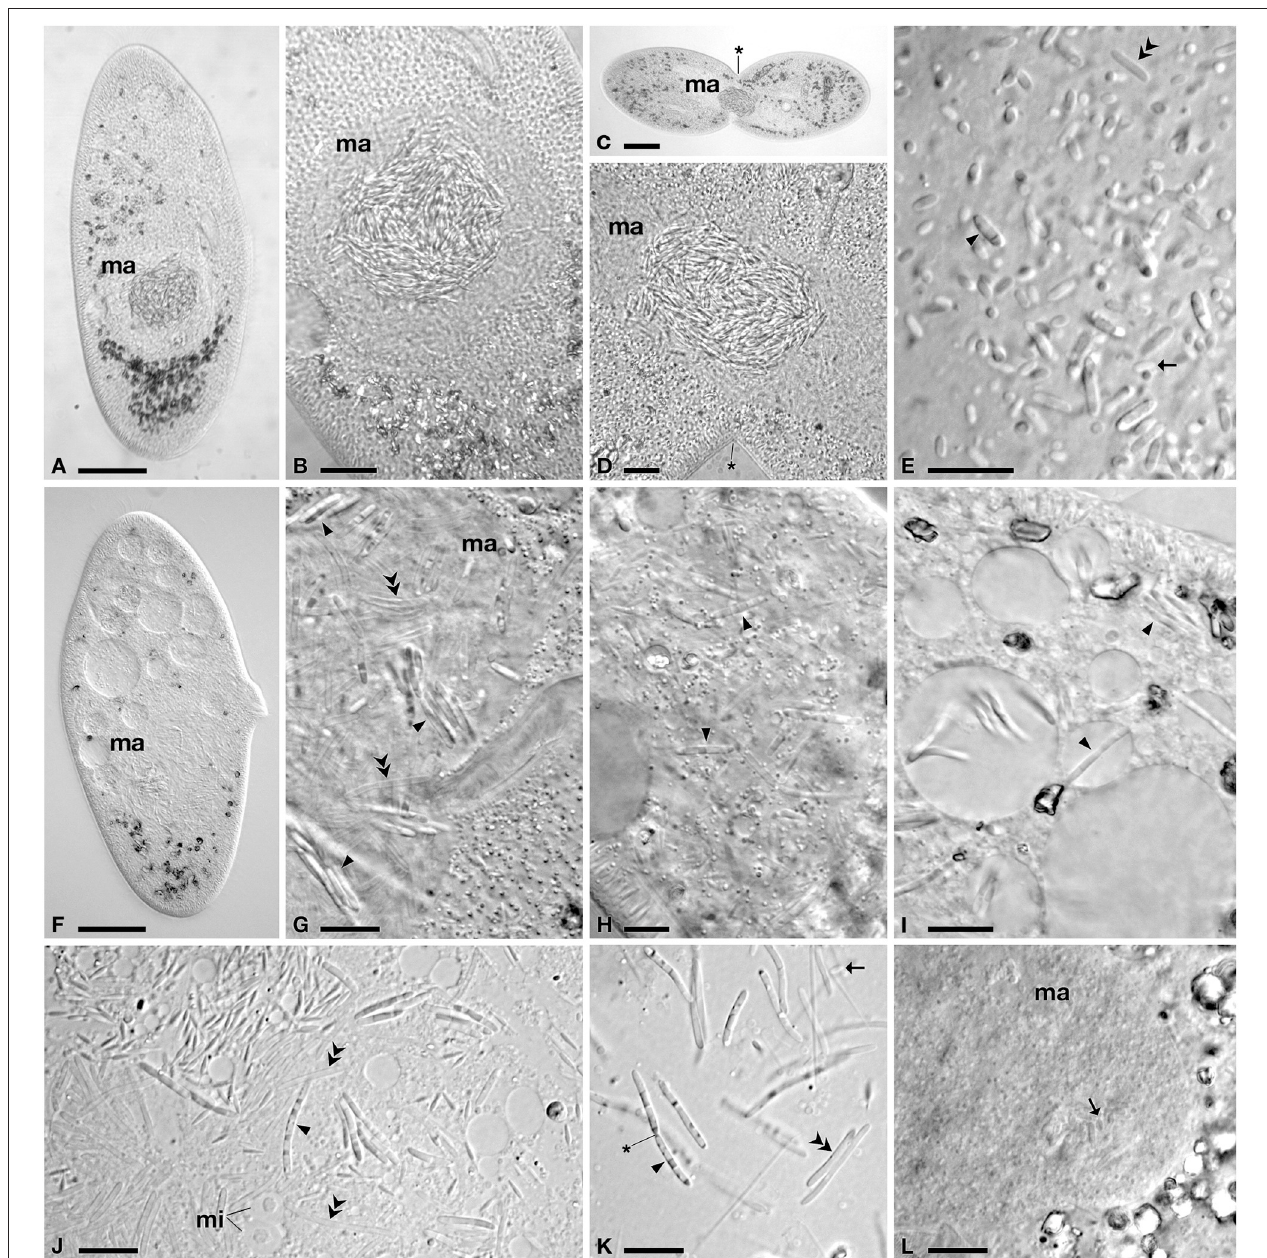
FIGURE 1 | Light microscopy of infected cells of P. multimicronucleatum . (A–E) TP2 cells a few weeks after environmental sampling and (F–K) after 1 year in culture. (A) Whole cell with macronuclear infection. (B) Infected macronucleus ( ma ), with bacteria clustering inside. (C) Infected cell undergoing division and (D) detail of its ma , showing absence of connecting piece. (E) Bacterial forms released after ma squashing, showing classical size and morphology of reproductive ( rf ) and infectious ( if ) forms. (F) Whole cell with macronuclear infection after 1 year of cultivation, in which bacterial cells are less visible. (G) Detail of infected ma , in which if cluster together in small groups, among a large number of transient forms ( tf ). (H) if in host cytoplasm. (I) Detail of if in host cytoplasm inside and outside vacuoles. (J) Detail of host vesicular type micronuclei ( mi ) and if , showing some changes in morphology, such as size and unusual striated/dotted pattern. (K) if undergoing binary fission and tf after cell squashing. (L) ma of strain PC6, infected by bacteria during cross-infection experiments, showing classical rf morphology. Arrowheads indicate infectious forms, arrows reproductive forms and double arrowheads transient forms. The asterisk indicates the cleavage furrow. Bars stand for 30 µ m (A,F) , 20 µ m (C,H) and 10 µ m (B,D,E,G,I–L) . daughter cells within MA pieces which, in many cases, were not equally shared in terms of size, suggesting that the bacteria interfere in host cell